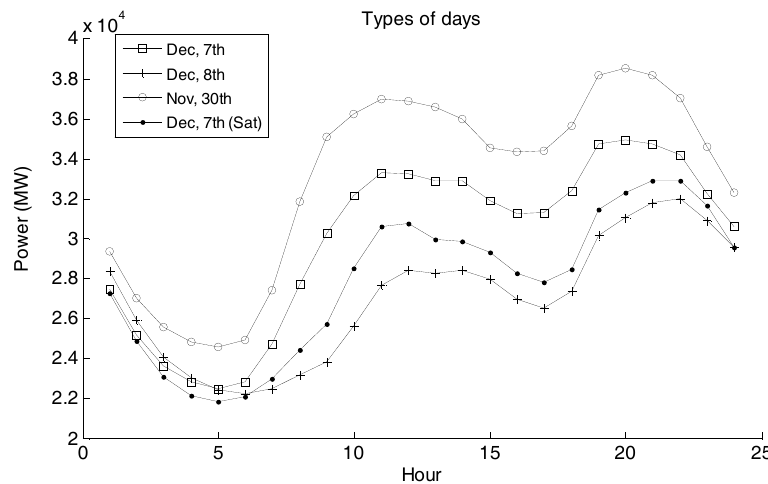
Figure 7. Different average profiles for national holidays, normal days, Saturdays and adjacent to holiday.